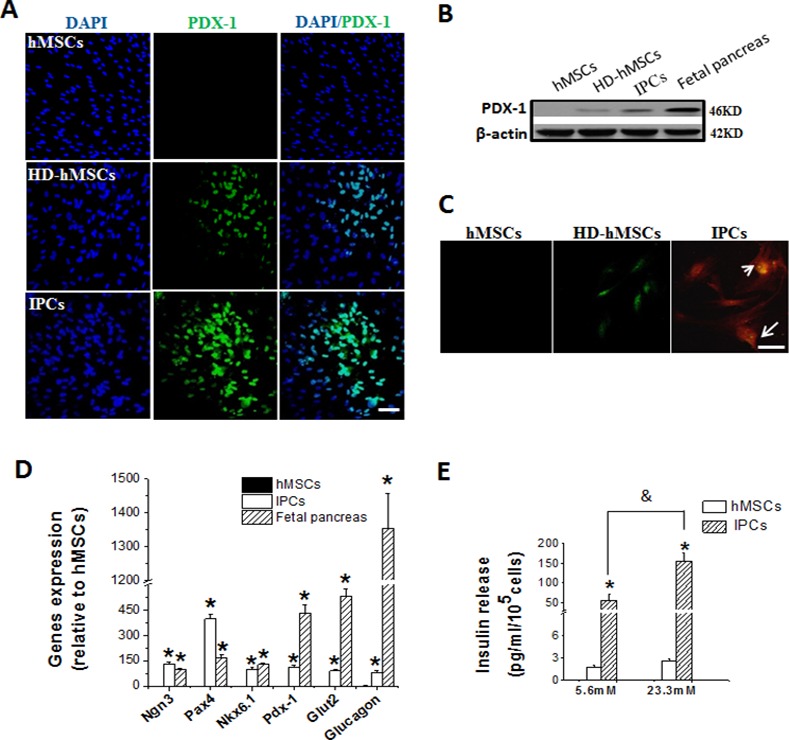
Gene expression and insulin-releasing functions of IPCs in vitro.hMSCs were induced and treated under the same condition described in Fig 2. A: Immunofluorescence staining for PDX-1 (green) and nuclear staining with DAPI (blue) on hMSCs, HD-MSCs and IPCs. The PDX-1 staining in hMSCs was negative, while HD-MSCs and IPCs expressed PDX-1 in nuclei (green). B: Western blot showed that PDX-1 was activated in the induced cells (HD-hMSCs) and the expression of PDX-1 was significantly elevated in IPCs. C: The cell aggregates/clusters from HD-hMSCs and IPCs groups were picked, digested and re-cultured to get the monolayer cells, and the co-staining for PDX-1 (green) and c-peptide (red) was performed on the monolayer cells. hMSCs were negative for both PDX-1 and c-peptide, and HD-hMSCs only expressed the PDX-1, while the monolayer cells from IPCs co-expressed PDX-1 and c-peptide. D: Expression levels of Pdx1, Ngn3, Pax4, Nkx6.1, Glut2 and glucagon genes by quantitative real-time PCR test. The IPCs expressed Pdx1, Ngn3, Pax4, Nkx6.1, Glut2 and Glucagon, similar to the expressing of fetal pancreas. E: The human insulin secreted by IPCs in response to glucose stimulation was examined by ELISA assay. Insulin released amount was calculated by insulin secreted in the culture medium for 2 h after 5.6mM and 23.3mM glucose stimulation. Compared to hMSCs, IPCs show the insulin secretion in a glucose dose-dependent manner. Data are presented as means ± SD from the 3 independent experiments (*P<0.05 compared to hMSCs; &P<0.05 compared between 5.6mM and 23.3mM glucose groups). Scale bars: 50μm for A and C.